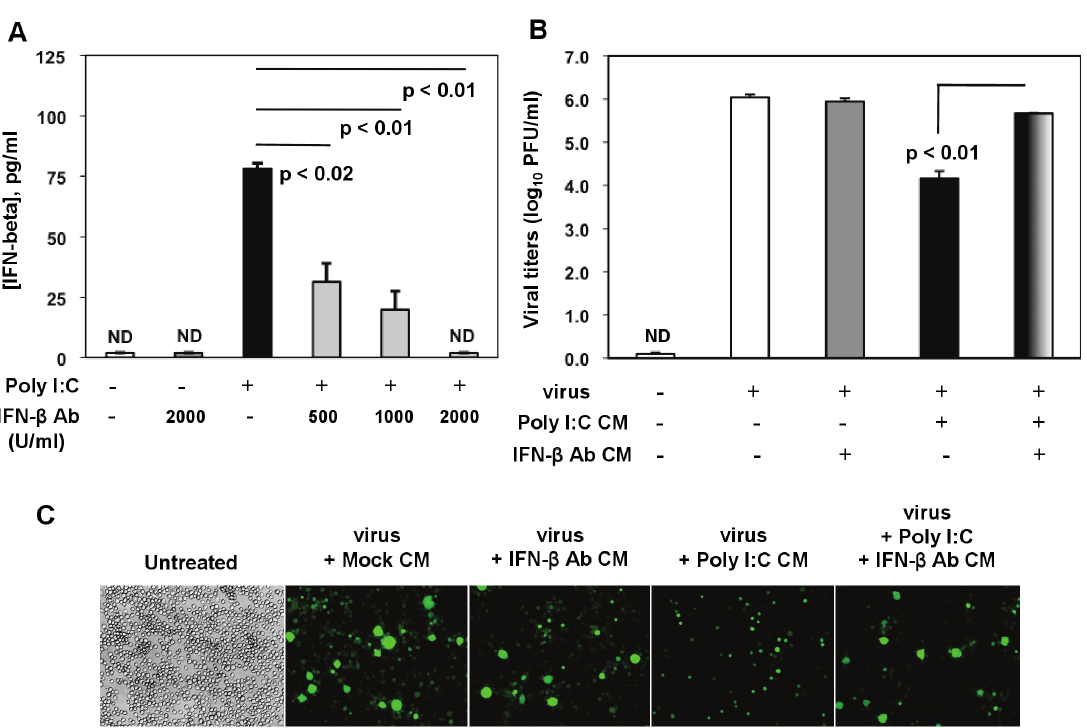
Figure 8. Role of IFN- β in poly I:C-triggered anti-viral response in MHV-infected macrophages. ( A ) Anti-IFN- β Ab was titrated in the presence of poly I:C in J774A.1 macrophages. Cells were activated with 0.25 μ g/mL poly I:C with or without anti-IFN- β Abs at 500, 1000, 2000 U/mL. Supernatants were collected after 6 h, cleared of cell debris and assessed with IFN- β ELISA. Error bars represent the standard error of the mean of two replicates (p value relative to cells activated with poly I:C alone, Student’s t test). ND, not detected; ( B ) RA59-GFP titers were assessed in cell-free supernatants from ( C ) using a plaque assay on L2 fibroblasts. Error bars represent the standard error of the mean of two replicates (p value relative to cells pre-treated with Poly I:C conditioned medium, Student’s t test); ( C ) J774A.1 macrophages were pretreated for 3 h with the conditioned medium (CM) from the anti-IFN- β Ab titration assay in ( A ). CM was diluted 1:1 with the basal medium to replenish nutrients. Then cells were infected with RA59-GFP (1 MOI) for 1 h adsorption and incubated in the basal medium for up to 18h p.i. Cells pretreated with the CM from mock cells or fresh basal medium (untreated) served as negative controls for the poly I:C+/-anti-IFN- β Ab-triggered effect. RA59-GFP infection was visualized at the original magnification x100. The data shown are representative images of two independent wells per treatment ( p values, Student’s t